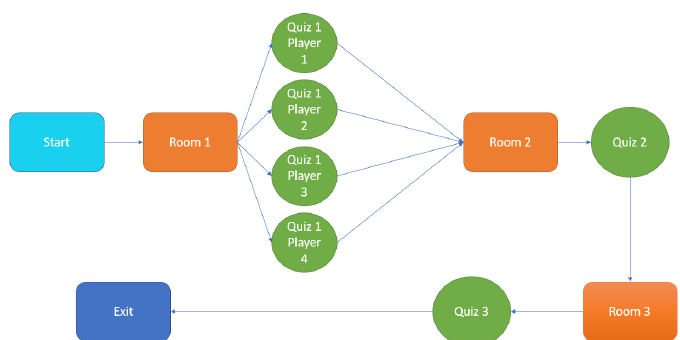
Figure 2. Basic scheme of an escape room to be played in parallel during the first quiz.